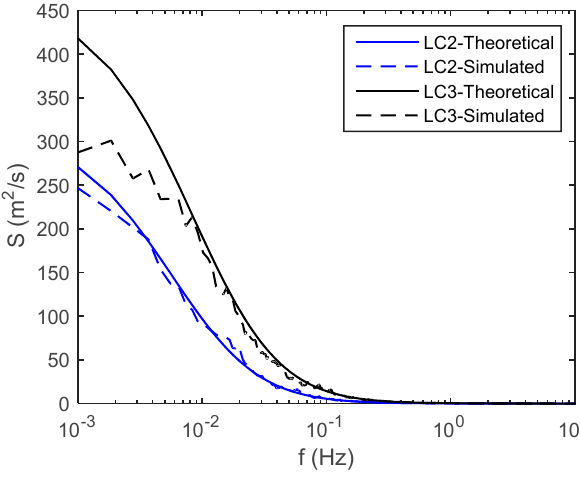
Figure 9. Kaimal wind spectra at hub height of FOWT-SFFC for LC2 and LC3.